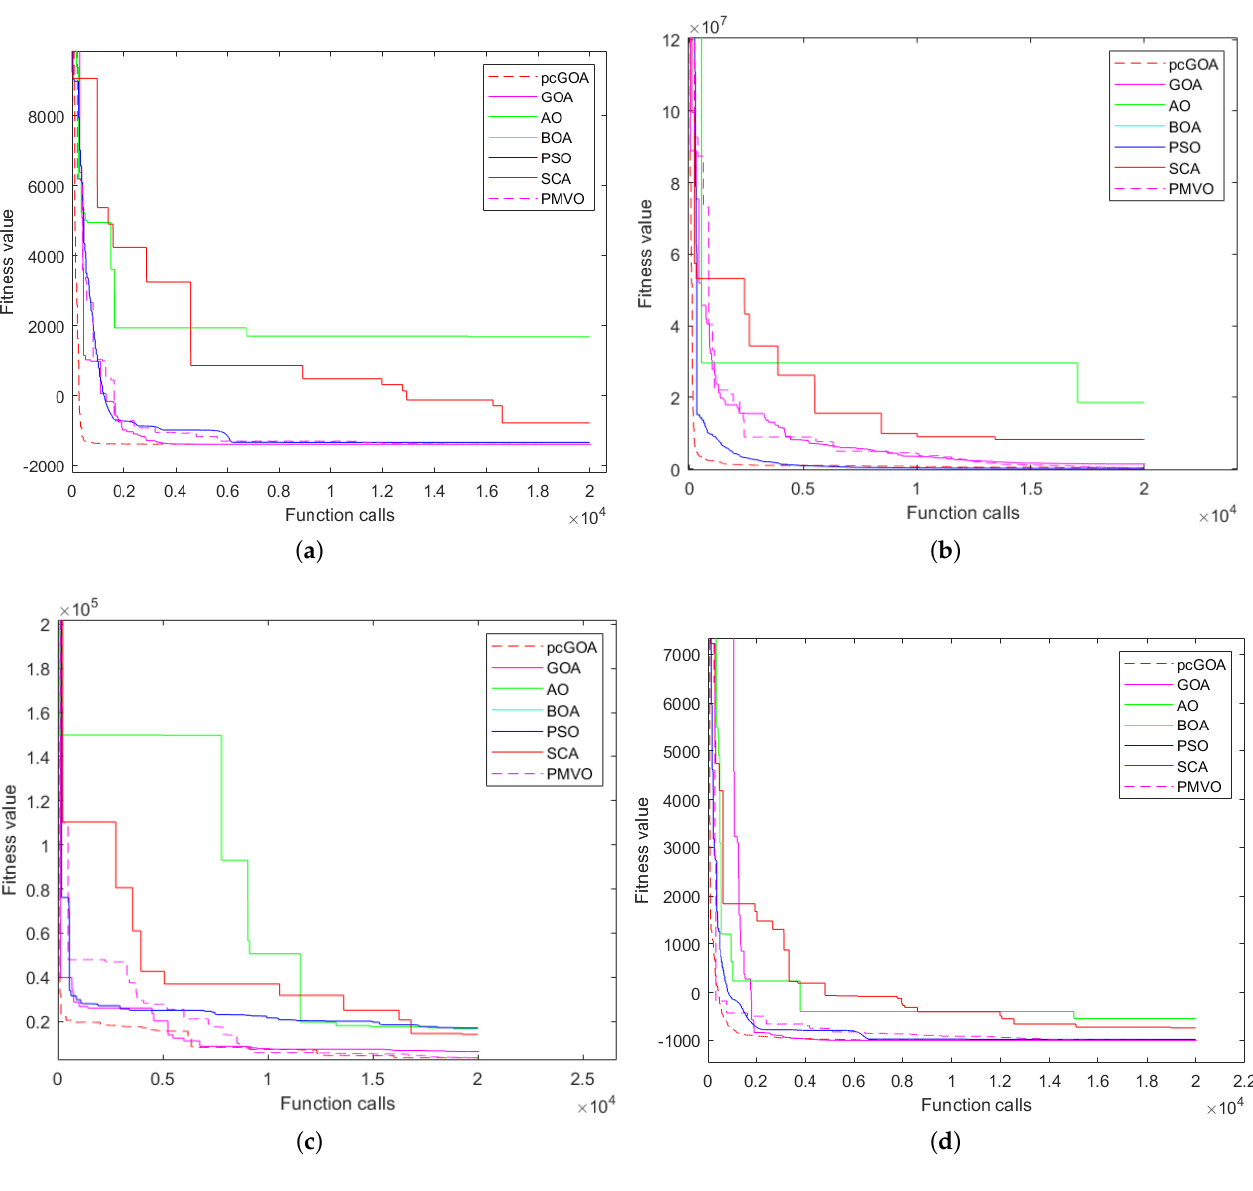
Figure 3. The convergence trend of the unimodal state of the benchmark function in CEC2013. ( a ) F1. ( b ) F2. ( c ) F4. ( d )